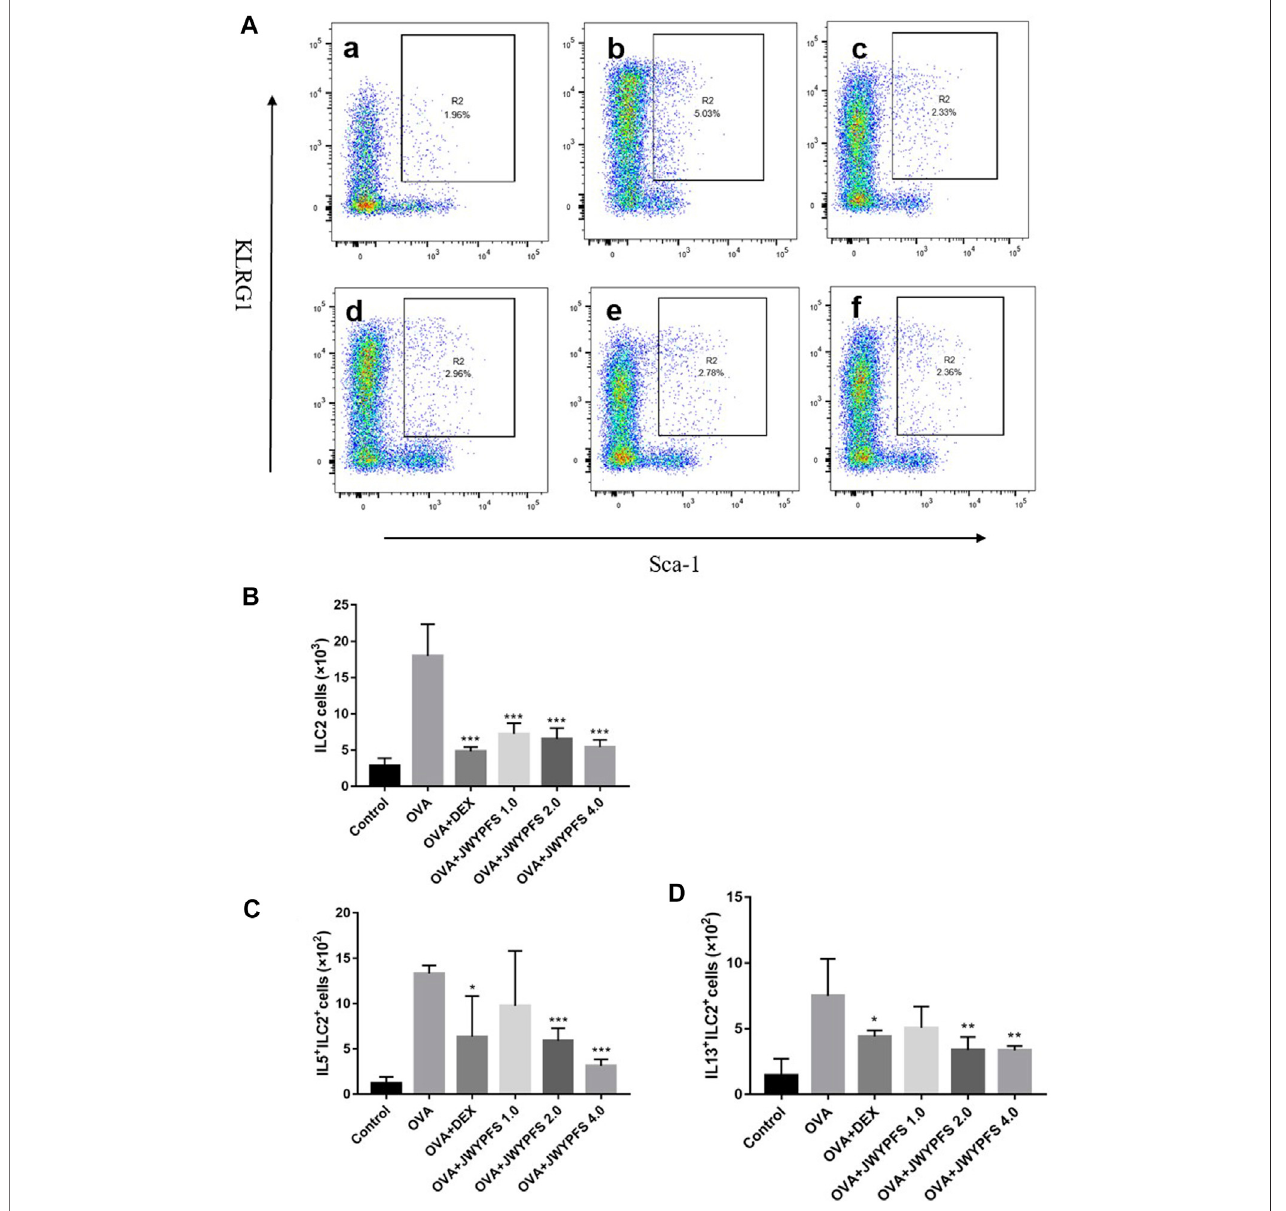
FIGURE4| TheeffectofJWYPFSonILC2sinlungtissue. (A) FlowcytometricanalysisofthepercentageofCD45 + Lineage − Sca-1 + KLRG1 + ILC2sineachgroup.a: control; b: OVA; c: OVA + DEX; d: OVA + JWYPFS 1.0; e: OVA + JWYPFS 2.0; f: OVA + JWYPFS 4.0. (B) Cell numbers of ILC2s in lungs. (C) IL5 + ILC2s in lungs. (D) IL13 + ILC2s in lungs. Data are shown as mean ± SD. * p < 0.05, ** p < 0.01, *** p < 0.001, compared with OVA group.